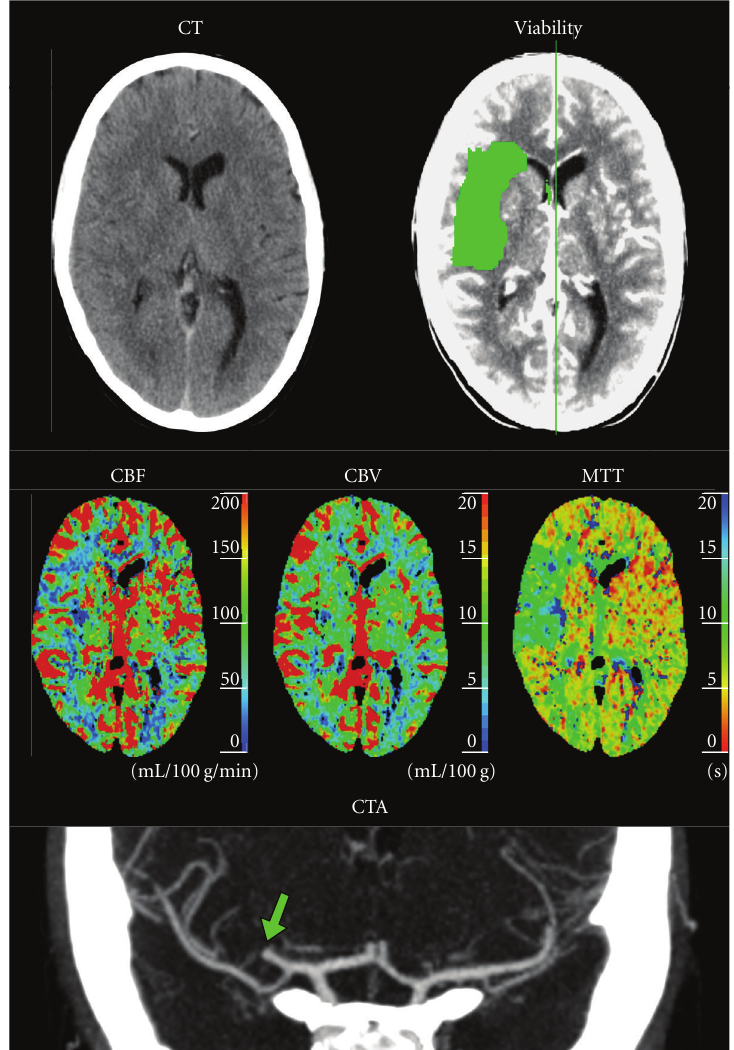
Figure 9: Case 4: 27-year-old woman with left-sided stroke symptoms of unknown onset and a normal NECT. The CTP viability map showed no ischemic core but a relatively large penumbra (green) in the right basal ganglia caused by a M2-segment MCA occlusion (arrow) seen on the